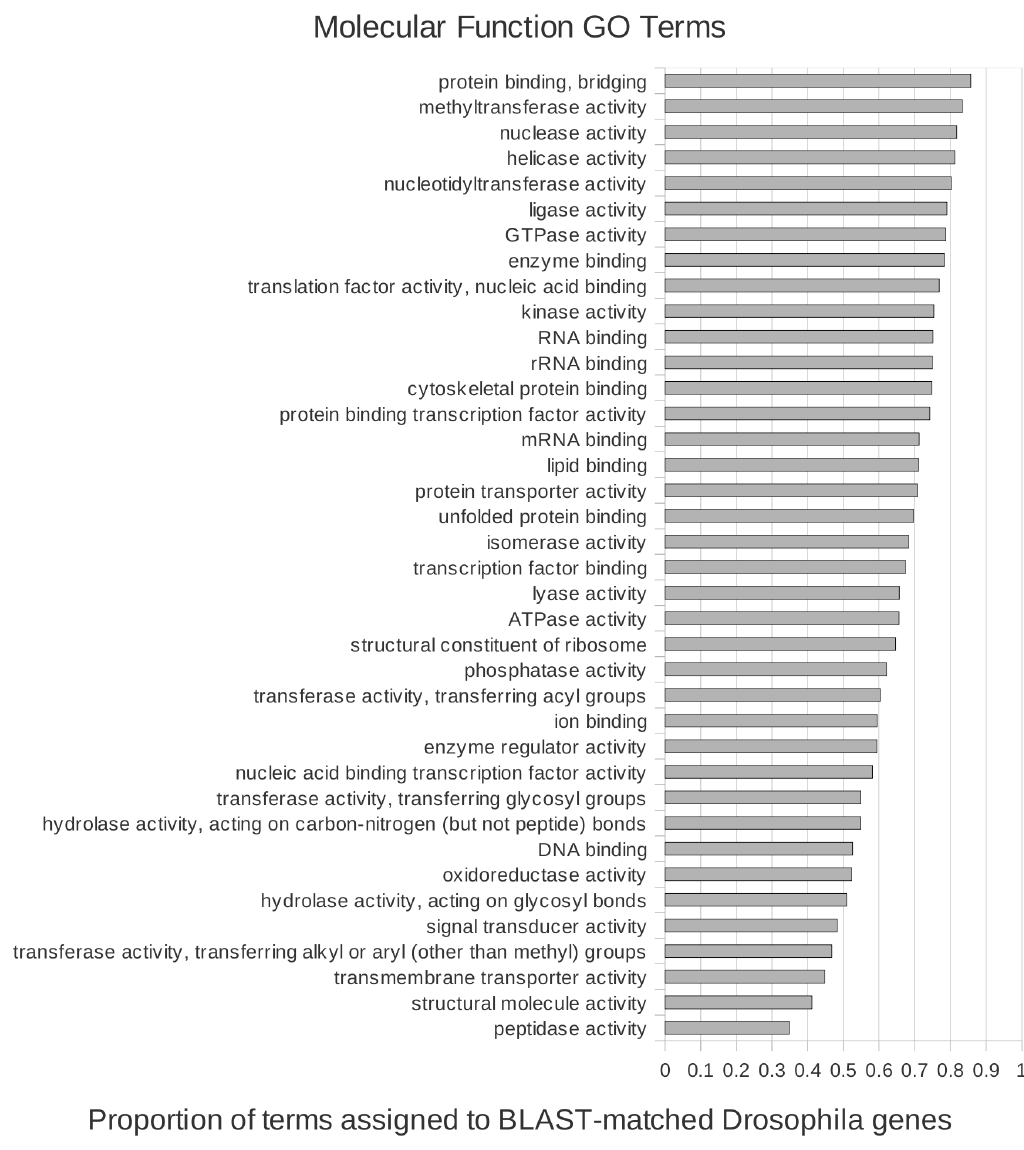
Figure 6. Relative conservation of homology between Elliptiocomplanata and Drosophilamelanogaster transcriptomes, by molecular function ontology term. The proportion of gene ontology terms assigned to D. melanogaster genes that were matched by BLASTX to E. complanata contigs, relative to the total number of D. melanogaster genes in each GO category.